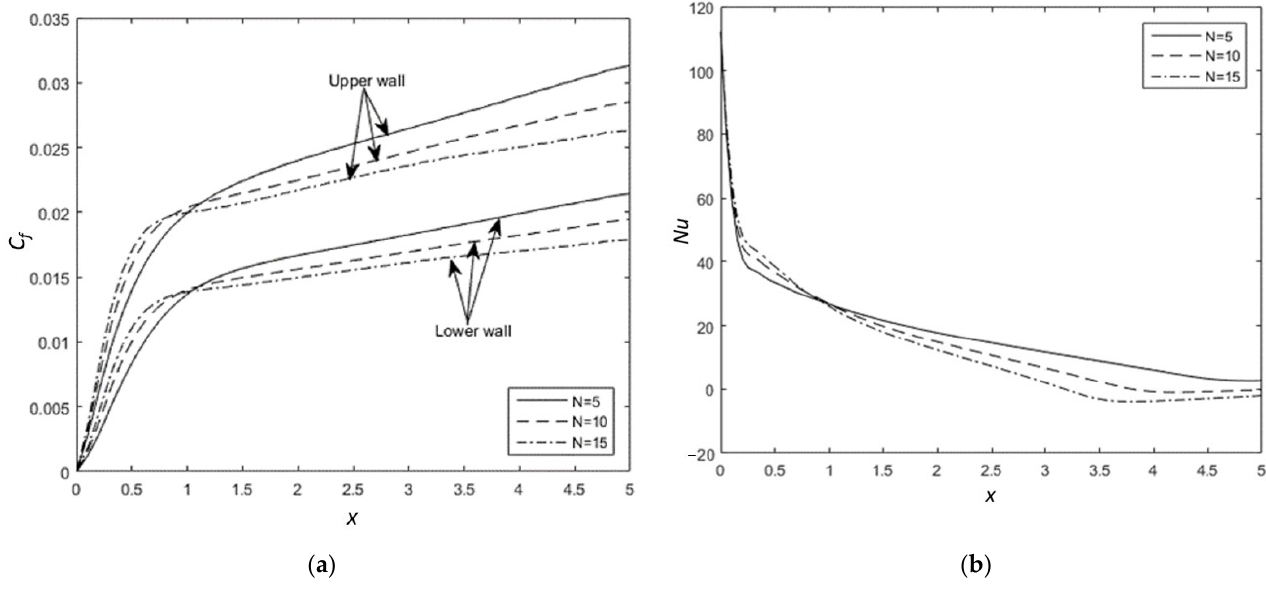
Figure 11. Wall Skin Coefficient and Nusselt number under different Stuart numbers: ( a ) Skin friction coefficient; ( b ) Nusselt number.